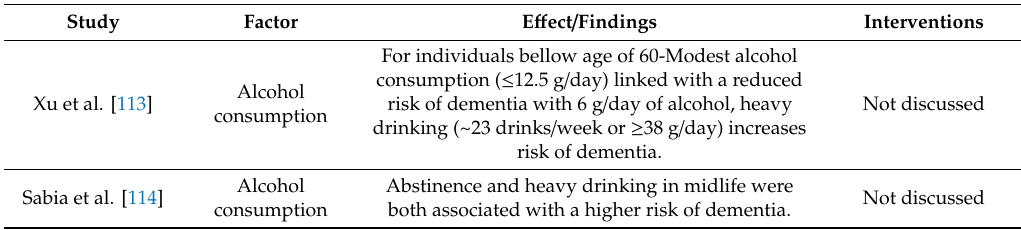
Studies associating addictive substances and cigarette smoking with the risk of dementia / Alzheimer’s